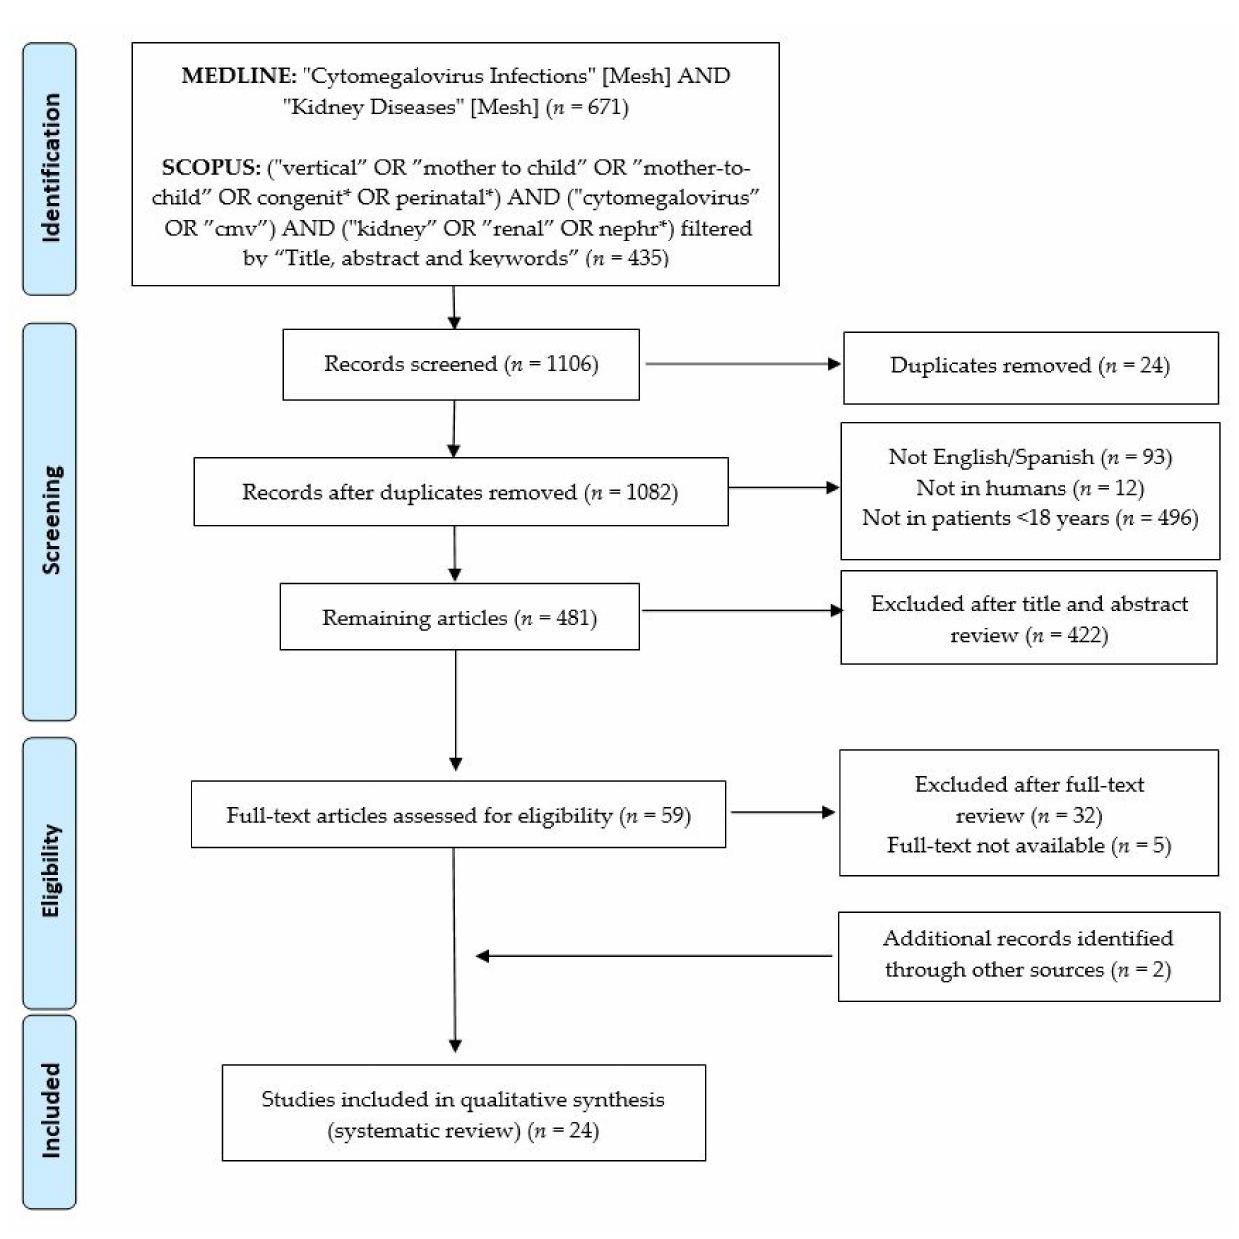
Figure 1. PRISMA flowchart of the current systematic review